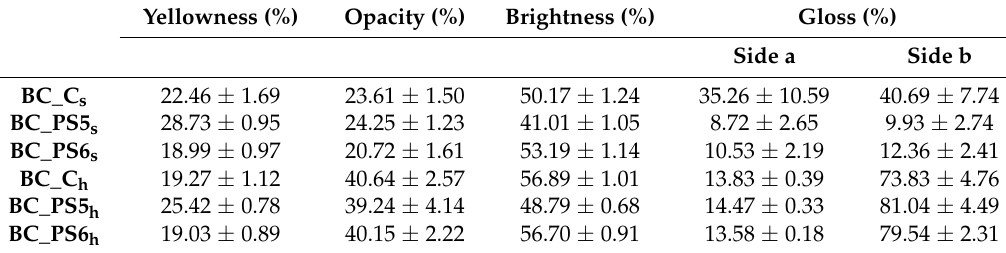
Table 4. Optical properties of the BC and modified samples with PS_5 and PS_6.